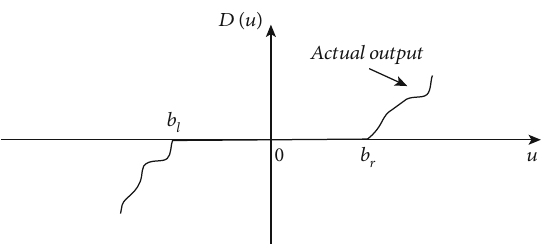
Figure 1: A typical example of thinking about deadzone